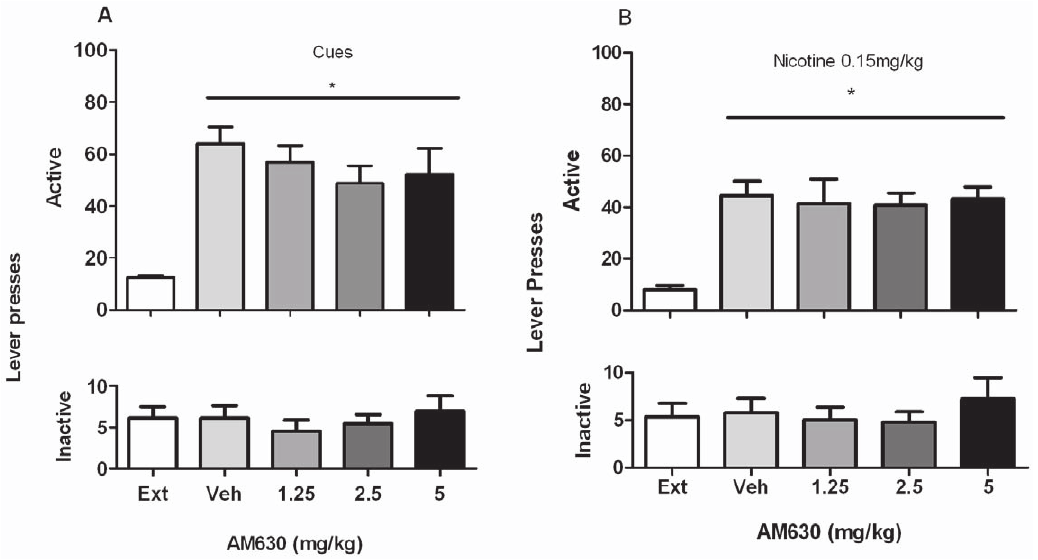
Figure 5. Effects of AM630 on reinstatement of nicotine-seeking behavior induced by presentation of nicotine associated cues and by Nicotine priming. A . Effects of pretreatment with AM630 (1.25, 2.5 and 5 mg/kg, IP H 30 min) on cue-induced reinstatement of nicotine-seeking behavior. A significant reinstatement of nicotine-seeking behavior was produced by presentation of nicotine-associated cues alone (* P , 0.001). ANOVA showed that pretreatment with AM630 (1.25, 2.5 and 5 mg/kg, IP, H 30 min) did not modify cue induced reinstatement of nicotine-seeking behavior compared to vehicle (0 mg/kg) pretreatment (P . 0.05). Data are expressed as means ( 6 SEM) of the number of active and inactive lever presses during extinction (Ext); vehicle (0 mg/kg) pre-treatment and after pretreatment with AM630 (1.25, 2.5 and 5 mg). B . A significant reinstatement of nicotine-seeking was also produced by pretreatment with nicotine (0.15 mg/kg) (* P , 0.001). ANOVA showed that AM630 (1.25, 2.5, 5 mg/kg, IP, H 30 min) did not modify reinstatement of nicotine-seeking behavior induced by a priming injection of 0.15 mg/kg nicotine administered 1 min before the session (P . 0.05). Data are expressed as means ( 6 SEM) of the number of active and inactive lever presses during extinction (Ext); vehicle (0 mg/kg) pre-treatment and after pretreatment with AM630 (1.25, 2.5 and 5